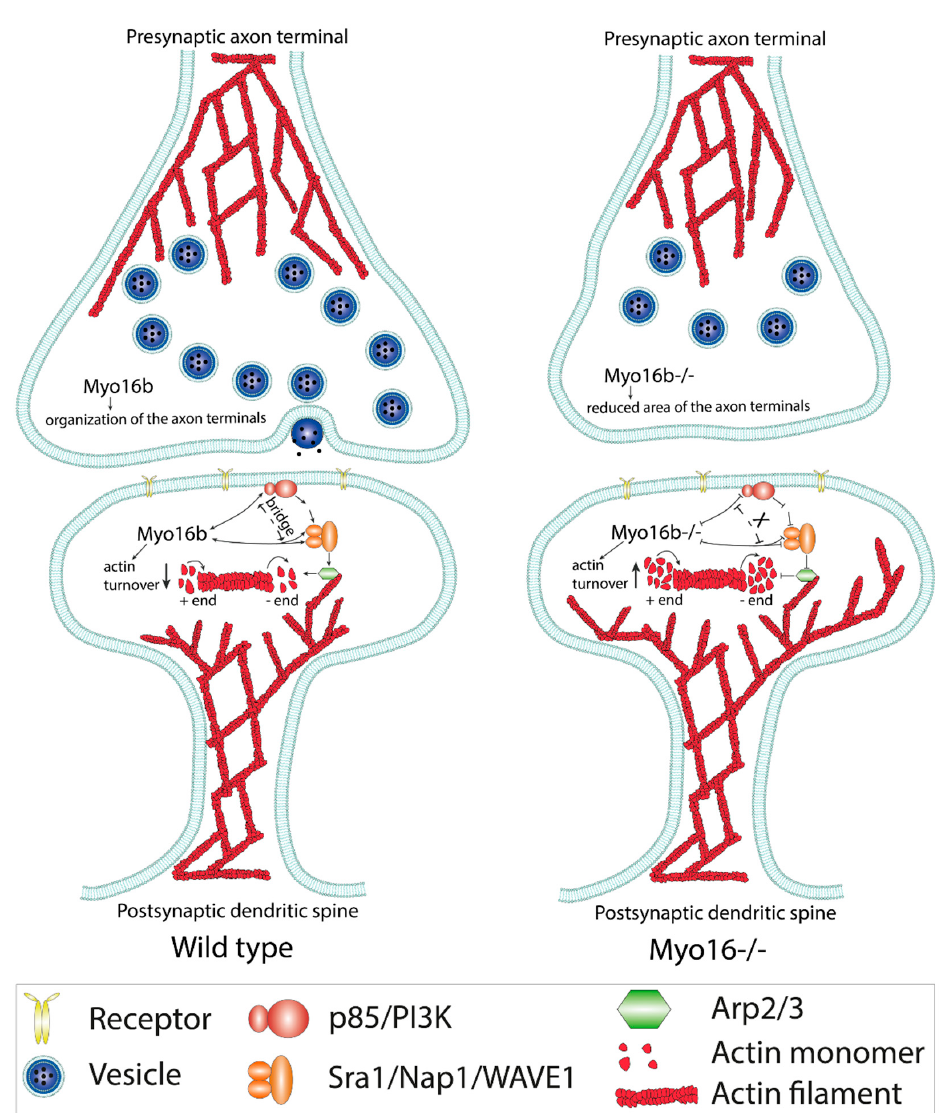
Figure 3. Schematic representation of the effects of Myo16 at parallel fiber-Purkinje cell synapses. Myo16 plays a role in the organization of the postsynaptic terminals of Purkinje cells by influencing the PI3K-WRC-Arp2/3 pathway that eventuates the downregulation of actin cytoskeleton dynamics. At the presynaptic site, Myo16 is implicated in the regulation of the number of synaptic vesicles, as well as of the morphological features of the parallel fiber terminal of granule cells. The X mark in the upper panel indicates the lack of interaction between Myo16, PI3K and WAVE1. The NYAP1-3 proteins are encoded by different genes (chromosomal location: NYAP1 7q22.1, NAPY2 2q36.3, NYAP3 13q33.3) [54]. The three NYAP proteins share the NHM region characterized